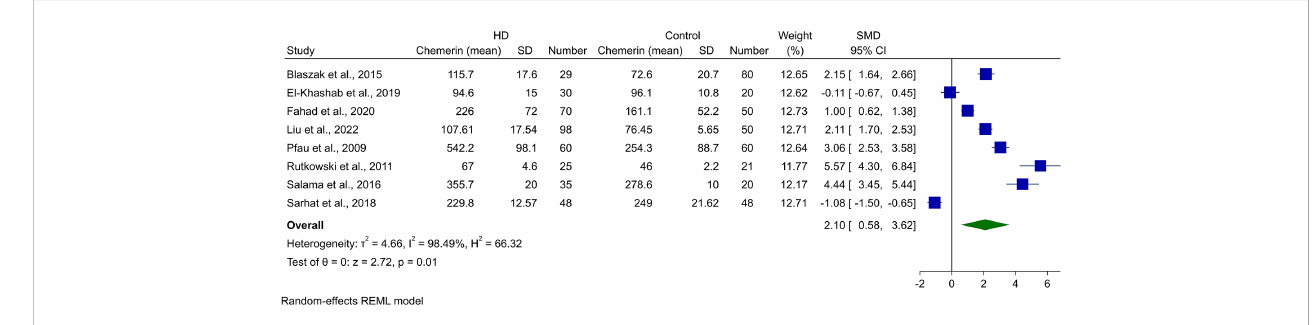
FIGURE 3 Forest plot for meta-analysis of chemerin levels in hemodialysis patients compared to controls.